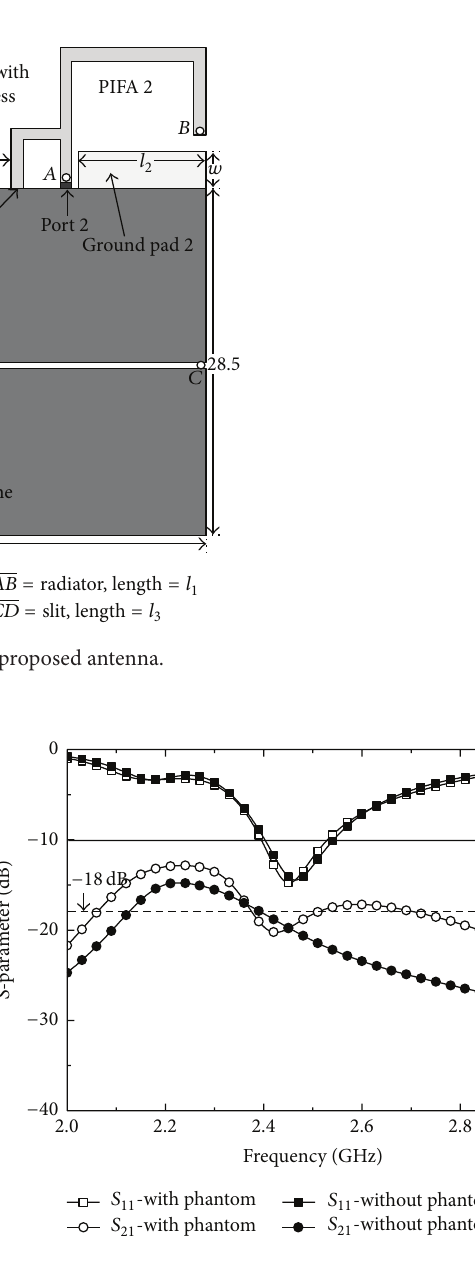
Figure 3: Simulated S -parameter results for the proposed antenna with phantom and without